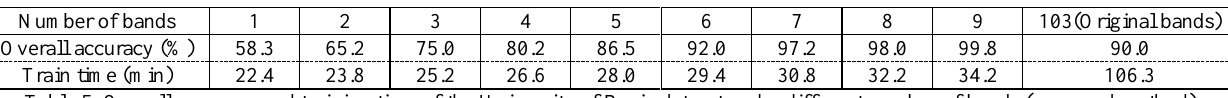
Number of bands 2 Overall accuracy (%) Table 6. Overall accuracy and training time of the Indian Pines dataset under different number of bands (proposed